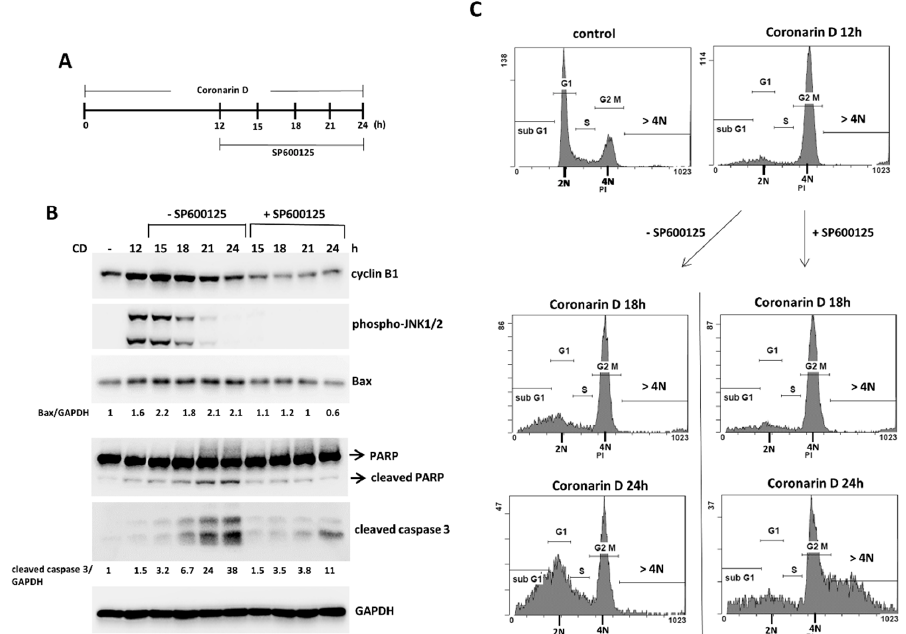
Figure 6. JNK inactivation eliminates the accumulation of cyclin B1 and induces polyploid in coronarin D-induced M phase arrest cells. ( A ) Schedule of drug treatment. HOS cells were treated with coronarin D for 12 h, and coronarin D treatment was continued with or without JNK inhibitor (SP600125) (20 µ M). The treated cells were harvested at the indicated time points and analyzed by Western blotting using the indicated antibodies ( B ) and by flow cytometry ( C ). Numbers indicate relative levels of Bax or cleaved caspase 3 after normalization to GAPDH ( B ).